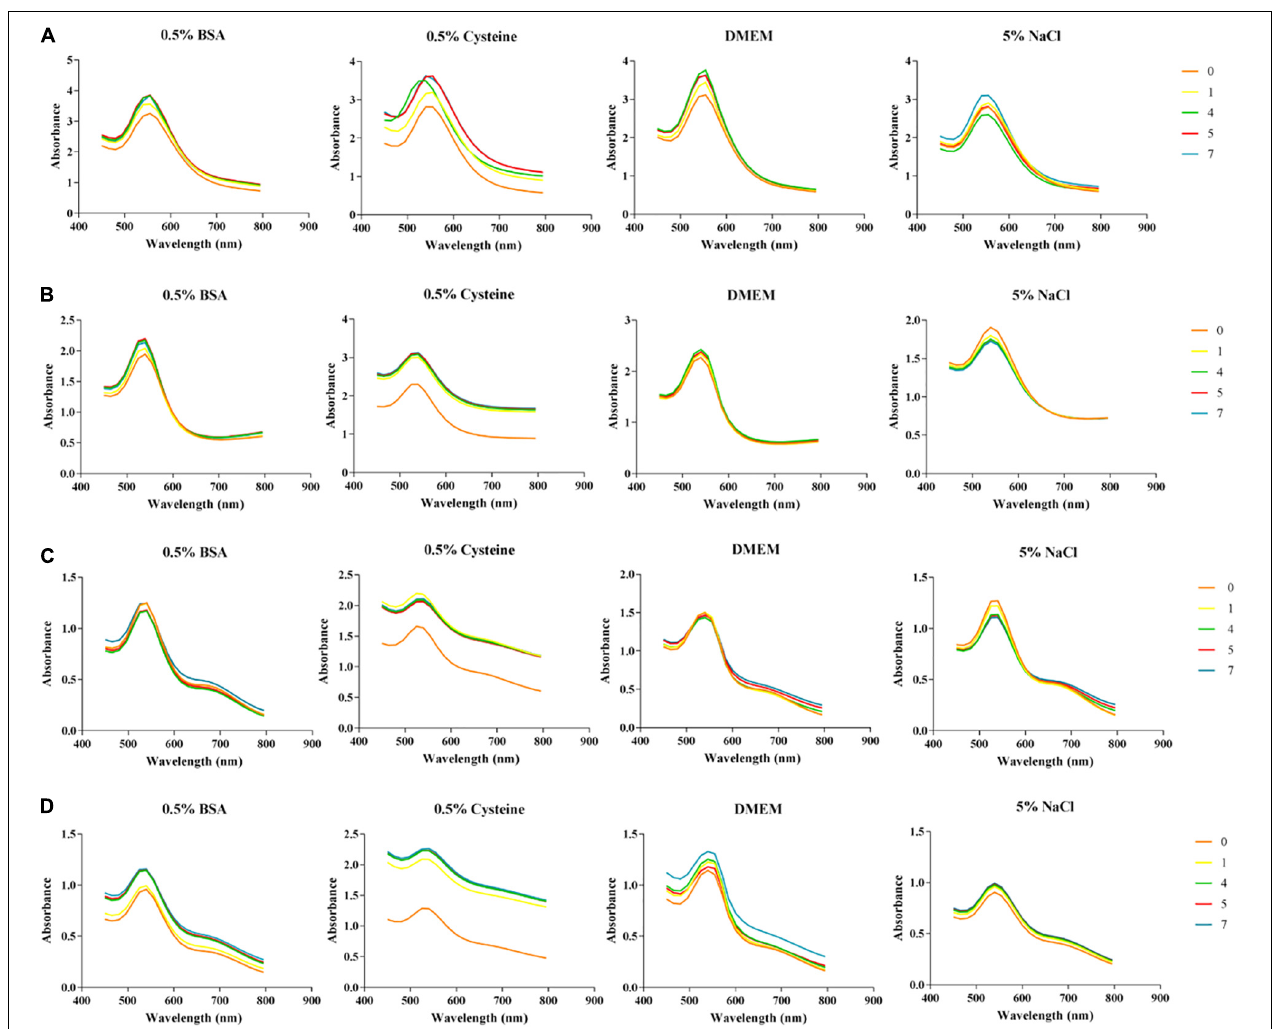
FIGURE 2 | Effect of biological salts and additives on the stability of (A) Helichrysum odoratissimum methanol extract + Gum arabic, (B) H. odoratissimum methanol extract – Gum arabic, (C) H. odoratissimum leaf powder + Gum arabic and (D) H. odoratissimum leaf powder – Gum arabic gold nanoparticles at pH 7 from 450 to 800